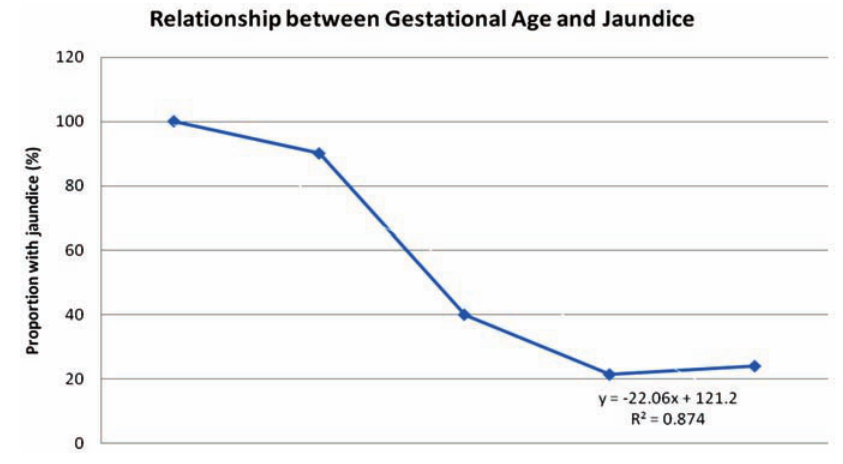
Figure 1. Relationship between gestational age and proportion of babies with